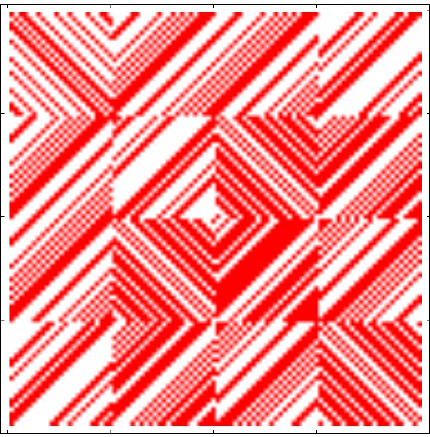
Figure 1: A visualization of the first solution of order 4 · 23 = 92. White indicates a value of +1, and red -1. We can see clearly the symmetry of the matrix, as well as the distinct blocks of the GP array.